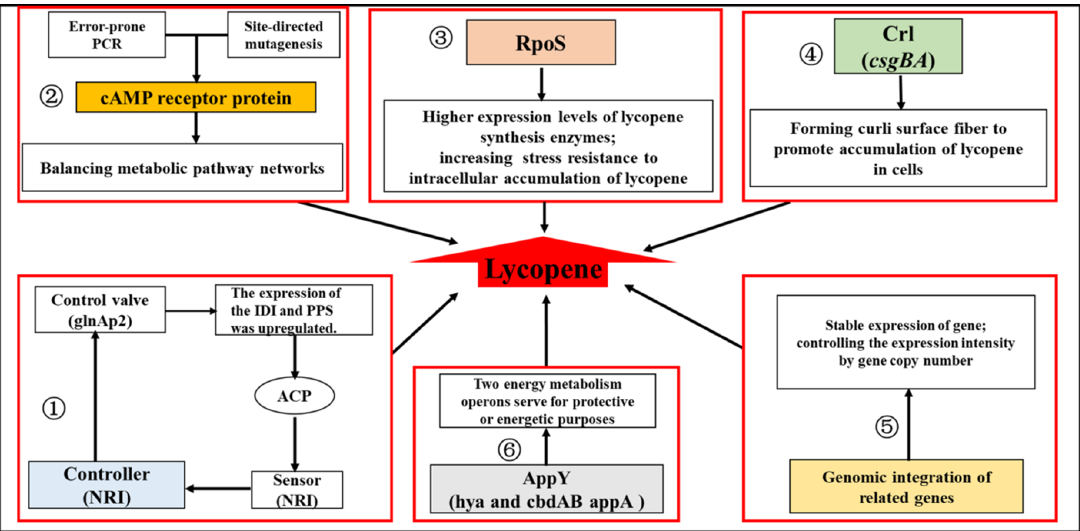
Figure 4. Summary of the strategies for engineering the regulatory networks to enhance lycopene production in E. coli . (1) Acetyl phosphate (ACP), as an indicator of glucose flux, was set as a signal of the two-component regulon Ntr, to regulate the expression of idi and pps for lycopene biosynthesis. (2) Transcriptional engineering on the global regulator cAMP receptor protein (CRP) was conducted by using error-prone PCR and site-directed mutagenesis, to subtly balancing the whole metabolic pathway networks for improving the lycopene yield. (3) RpoS regulates the transcription of genes induced at the stationary phase and energy metabolism. (4) Crl regulated the expression of csgBA for curli surface fiber formation to promote the accumulation of lycopene in cells. (5) Genomic integration of related genes made the expression stable and controlled the expression intensity by gene copy number. (6) The AppY transcriptional regulator was relative to anaerobic energy metabolism.